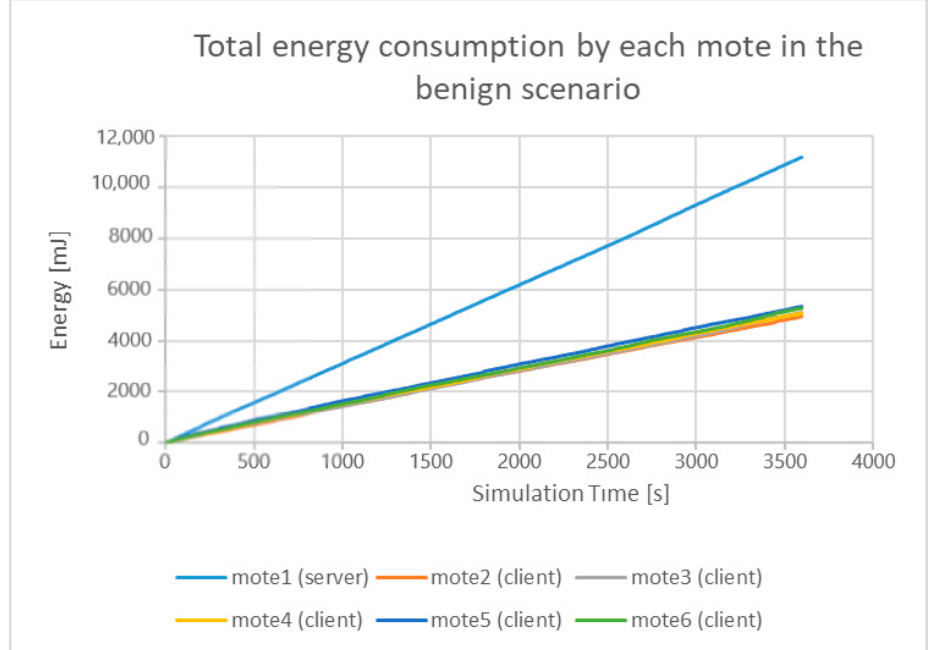
Figure 37. Total energy consumption by each mote in the benign scenario.